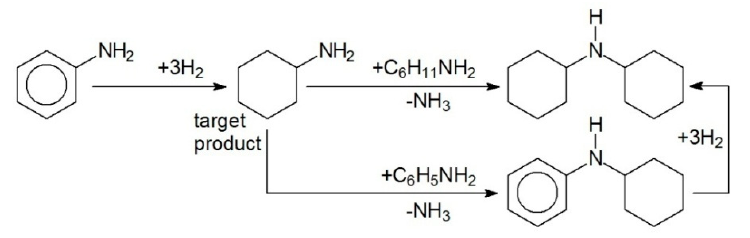
Figure 6. Simplified scheme of selective hydrogenation of AN to CHA.